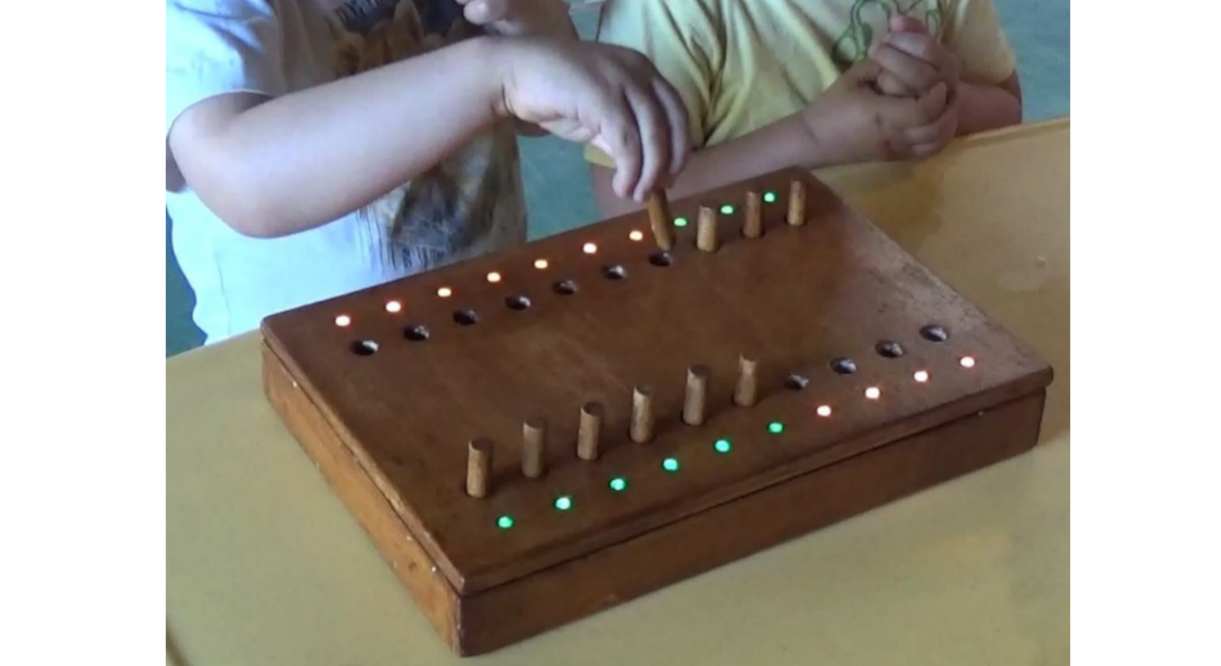
Figure 1. Snapshot of the prototype sensor-based pegboard being used by a